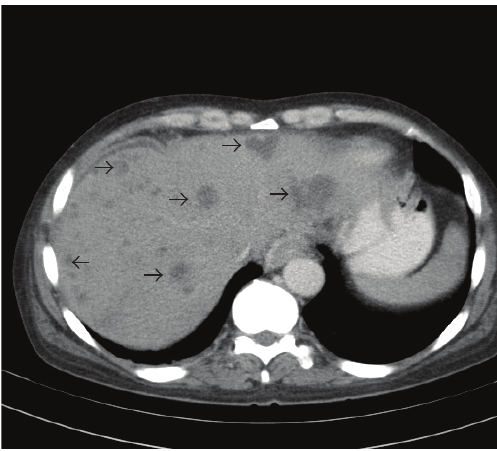
Figure 1: CT scan of the abdomen highly suspicious for multiple hepatic metastases.